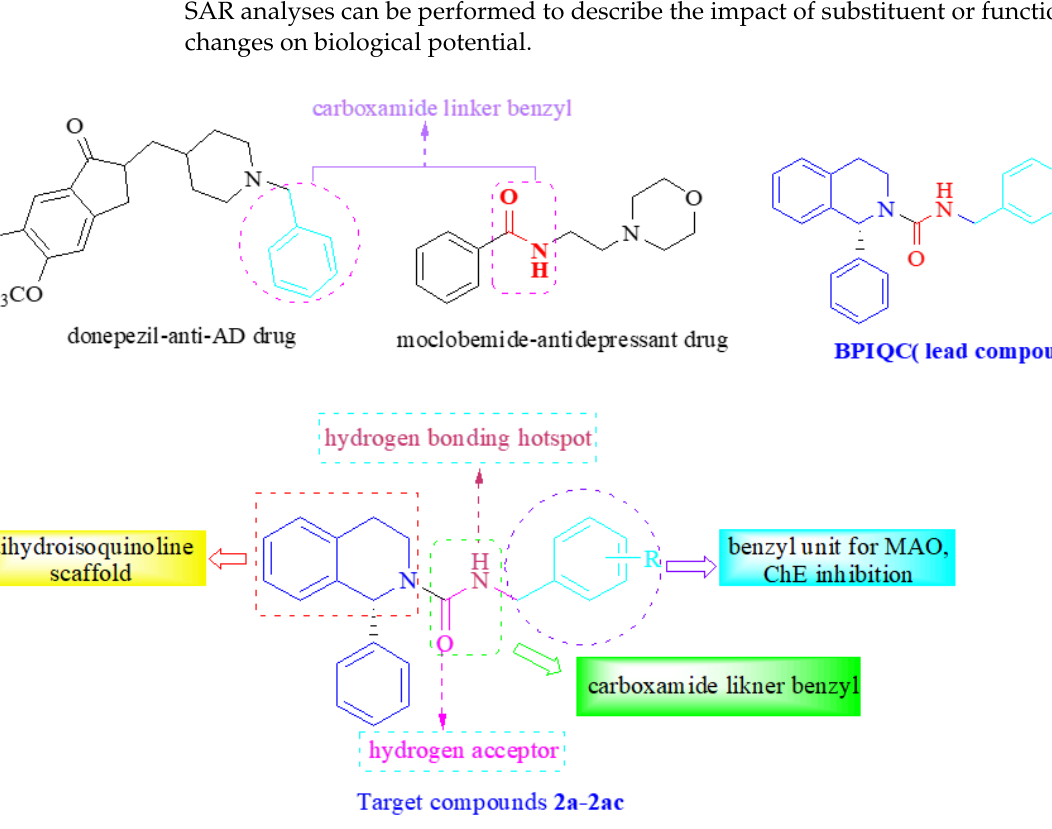
Figure 2. Design strategy for new target compounds 2a – 2ac .